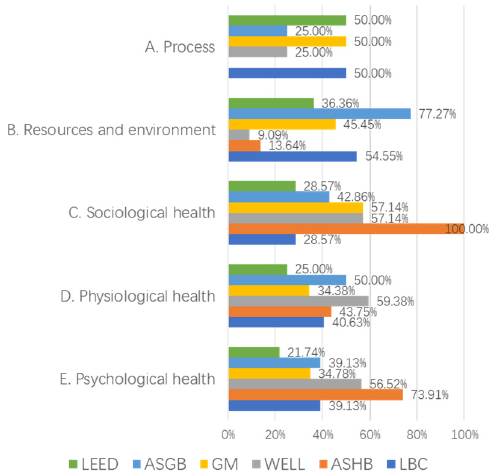
Figure 4. Breakdown of inclusion degree in five sections. (Source: by the author).